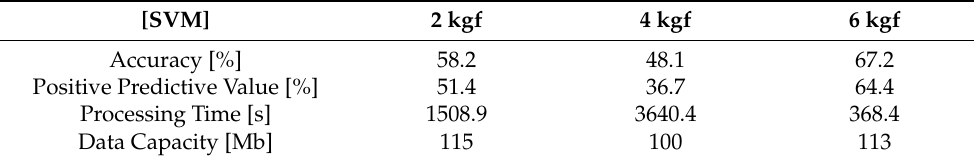
Table 4. Doctor blade tilting fault diagnosis based on raw data (i.e., Sensors 1, 2, and 3).